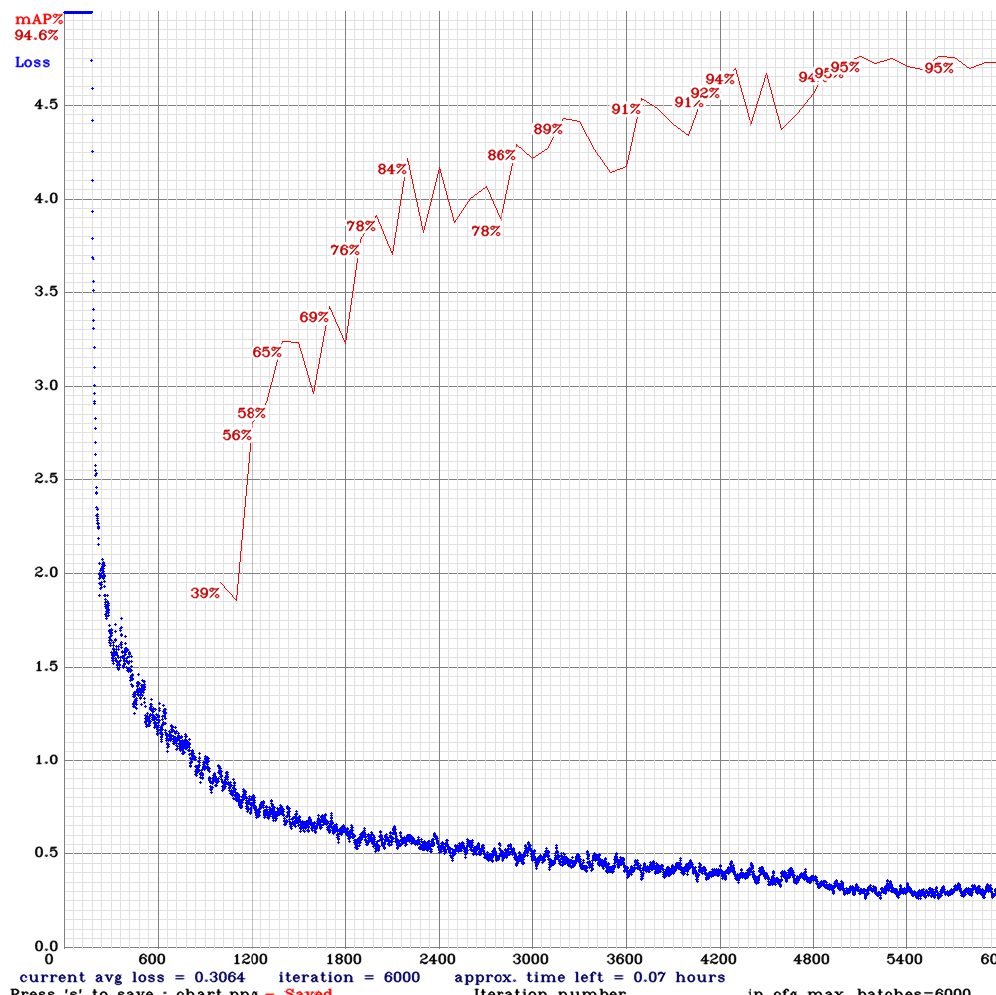
Figure 8. The result using 608 × 608 images with 6000